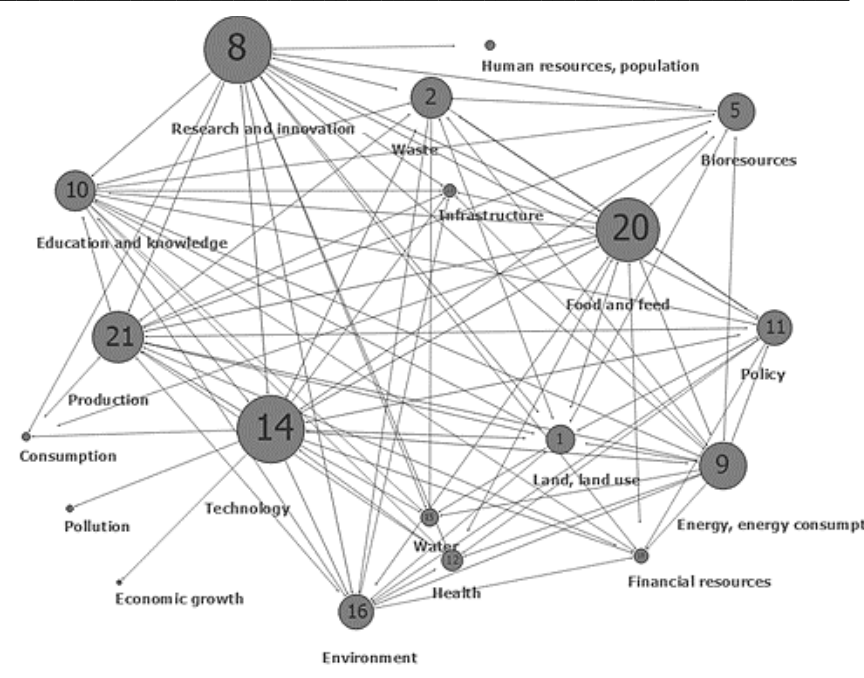
Fig. 2. Network of interactions between factors affecting the development of bioeconomy. Analysis of the media and social networks